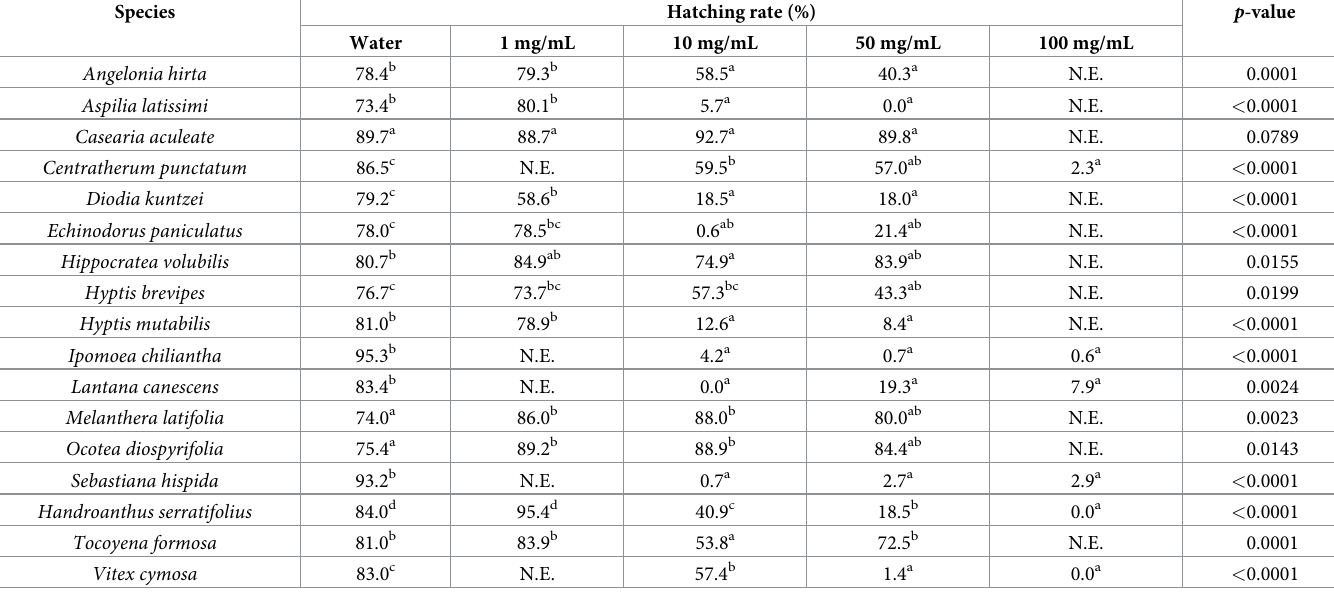
Table 2. Plant species, extract concentrations screened, hatching rates and p -values (water/extract concentration).